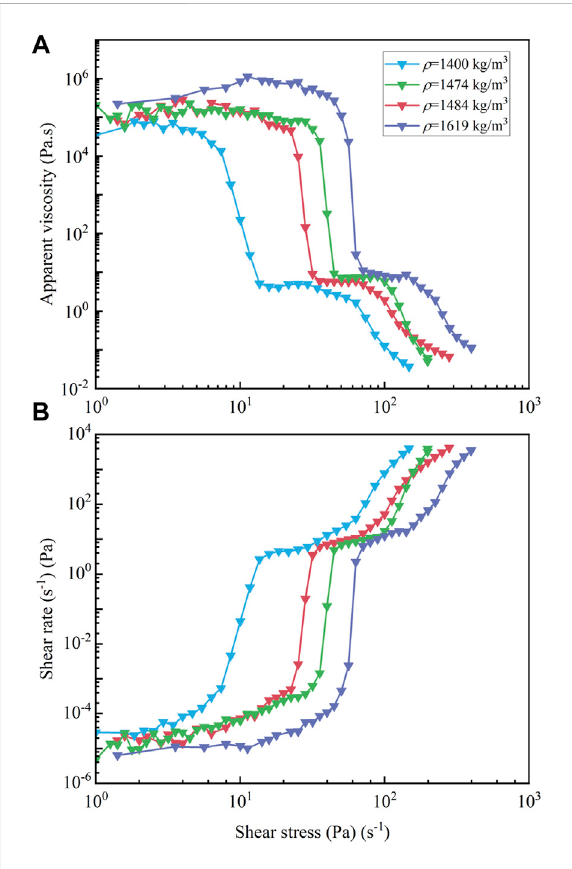
FIGURE 7 The apparent viscosity (A) and shear rate (B) evolution with increasing shear stress of the different mud